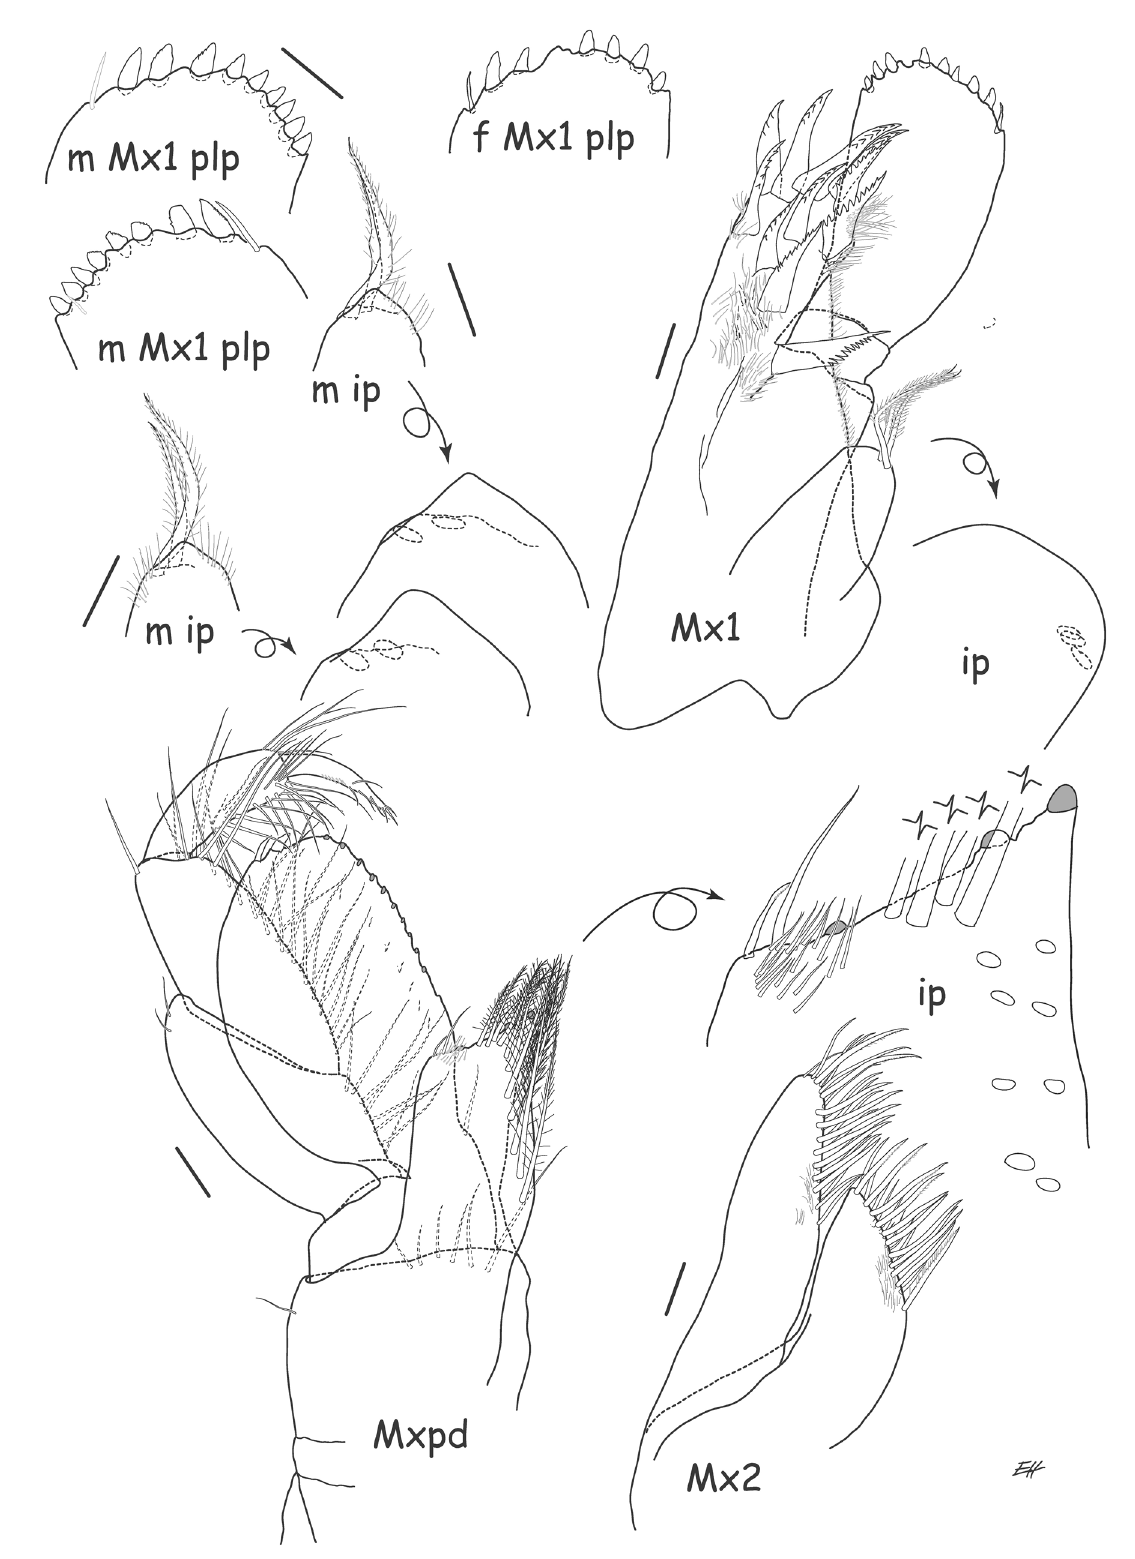
Fig. 21. Abyssorchomene scotianensis (Andres, 1983), ♀, 12 mm (CMNC 2022-0005); ♂, 12.4 mm (CMNC 2022-0007). Figures with sex not indicated are of female. Scale bars = 0.1